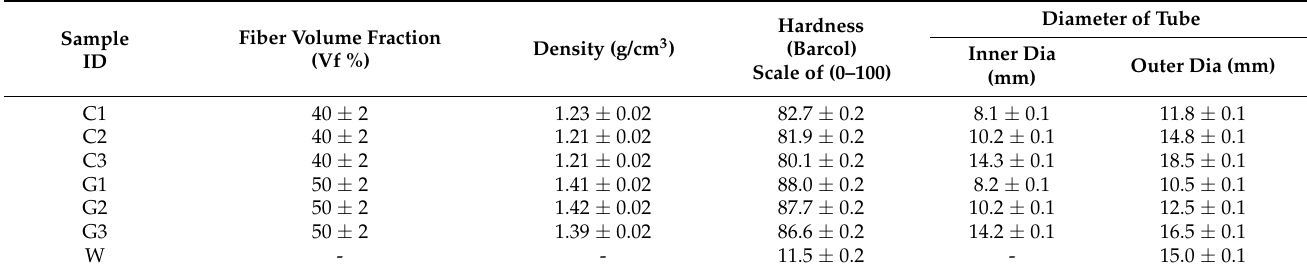
Table 2. Physical parameters of the developed composite samples.